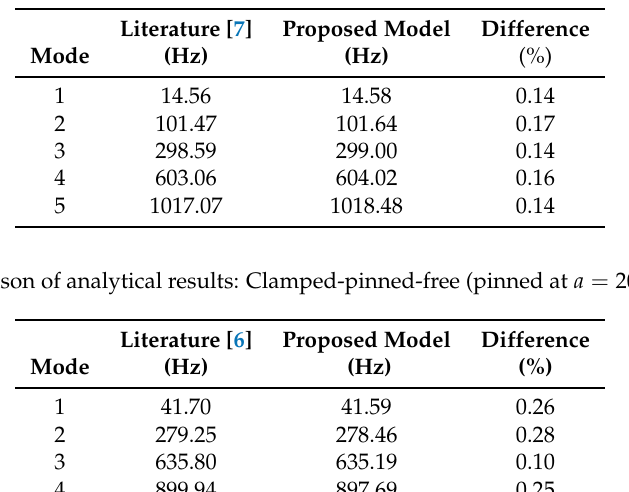
Table 2. Comparison of analytical results: Clamped-free with mass at free end ( m attached